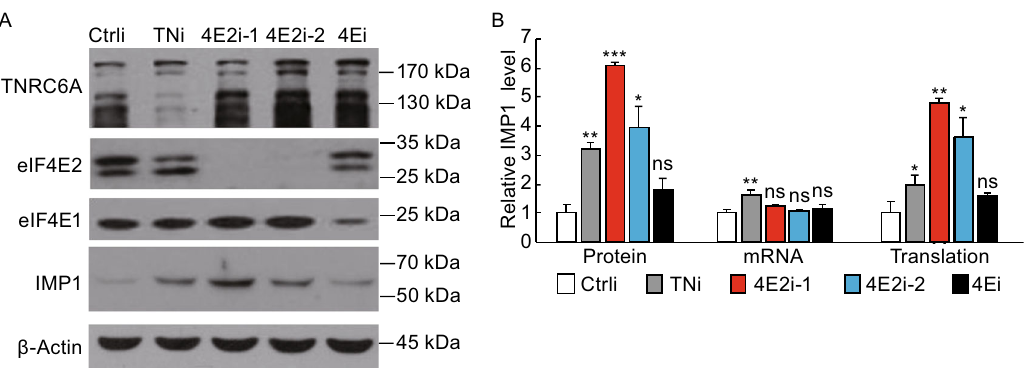
Figure 5. Downregulation of eIF4E2 increases the protein levels of endogenous IMP1. HeLa cells were transfected with siRNAs indicated. At 48 h posttransfection, cells were lysed. (A) A fraction of the lysate was subjected to SDS-PAGE followed by Western blotting. (B) The rest cell lysate was used to extract RNA, followed by RT-qPCR measurement of the RNA levels. Relative IMP1 protein levels were quanti fi ed with the Image J software and normalized with the β -actin levels. Translational ef fi ciency was calculated as relative protein level divided by mRNA level. Fold repression was calculated as the value in the presence of the control siRNA divided by that in the presence of the targeting siRNA. Data presented are means ± SD of three independent experiments. The P value is determined by two-tailed Student ’ s t test. ns, nonsigni fi cant. * P < 0.05; ** P < 0.01; *** P < 0.005. Ctrli, control siRNA;